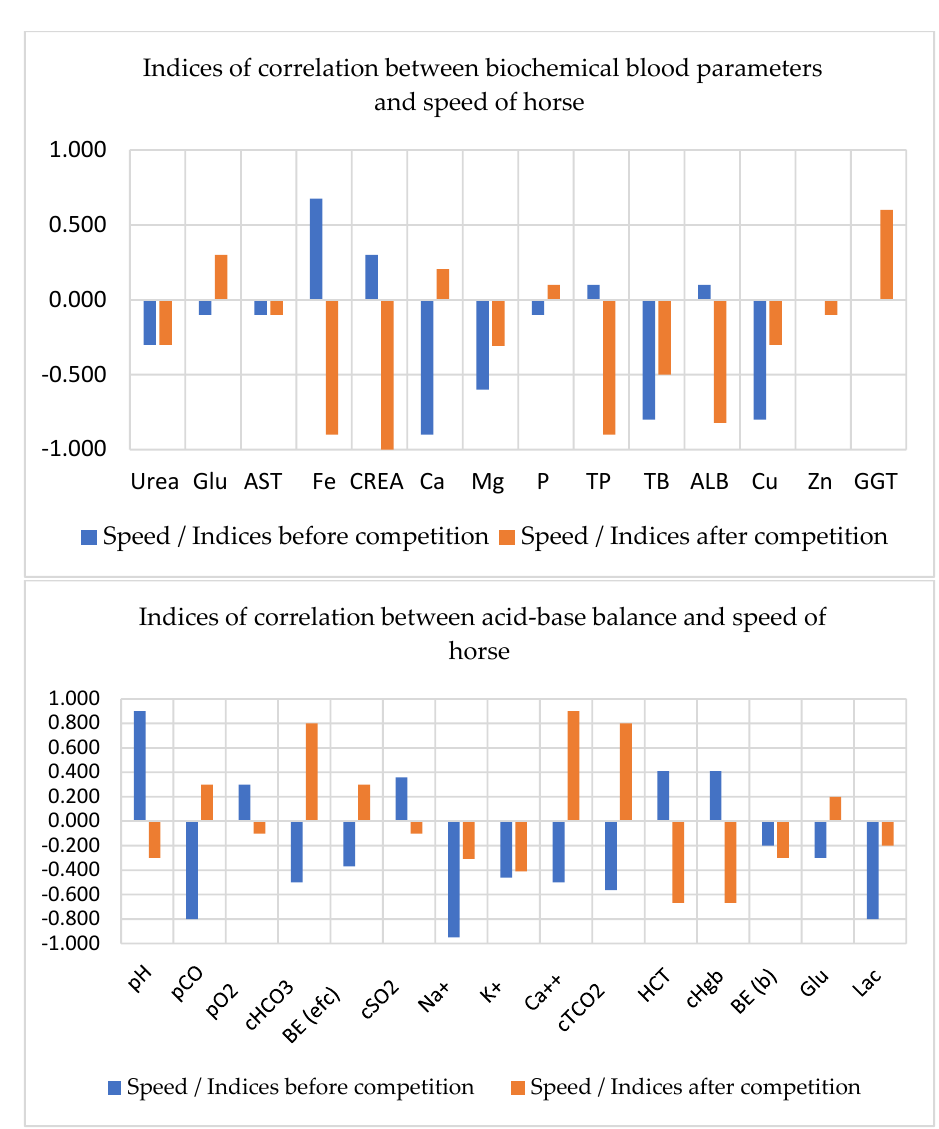
Figure 1. Correlations between blood indices and the speed of the Arabian horses. pH—hydrogen potential; pCO 2 —partial carbon dioxide pressure; pO 2 —partial oxygen pressure; BE—base excess in the blood; BE (efc)—base excess in the extracellular fluid; HCO 3 —bicarbonate; cSO 2 —oxygen saturation; tCO 2 —total carbon dioxide in the blood; HCT—hematocrit; Hgb—hemoglobin concentration; Glu—glucose; Na + —sodium; K + —potassium; Ca ++ —ionized calcium; Lac—lactate; Urea—serum urea; Glu—glucose; AST—aspartate aminotransferase; Fe—iron; CREA—creatinine; Ca—total calcium; Mg—magnesium; p —phosphorus; TP—total protein; TB—total bilirubin; ALB—albumin; Cu—cuprum; Zn—zinc; GGT—gamma ‐ glutamyl transferase.